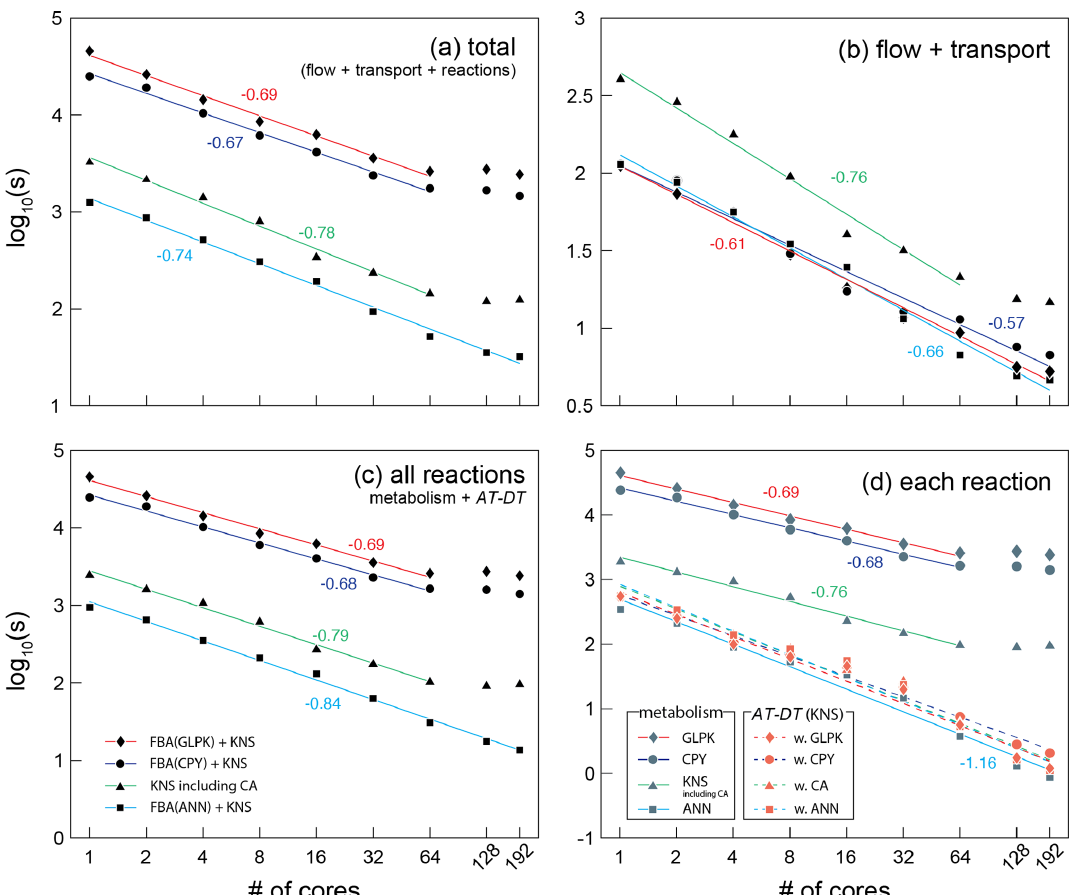
Figure 5. The wall-clock time recorded in seconds for (a) the total, (b) flow and transport, (c) all reactions, and (d) each reaction part of the CompLaB algorithm. Four different simulations were carried out deploying each reaction solver: three simulations used COBRApy (CPY), GLPK, artificial neural network (ANN) solvers for microbial metabolism calculation, and a kinetic solver (KNS) for the attachment/detach- ment of biomass (AT-DT). One simulation used only a kinetic solver for both microbial metabolism and AT-DT with the cellular automaton algorithm invoked (CA). The simulation time for CA only can be inferred by subtracting the time for AT-DT with CA (dashed green line with orange triangle symbols) from the time for KNS including CA (solid green line with gray triangle symbols) in (d) . Each symbol represents the average of two simulations. The simulations exhibiting no or limited speed-up with 128 and 192 cores except the ANN simulation were excluded when drawing the regression lines. The negative numbers are the slopes of the solid regression lines. The average slope of all the dashed regression lines in panel (d) is −